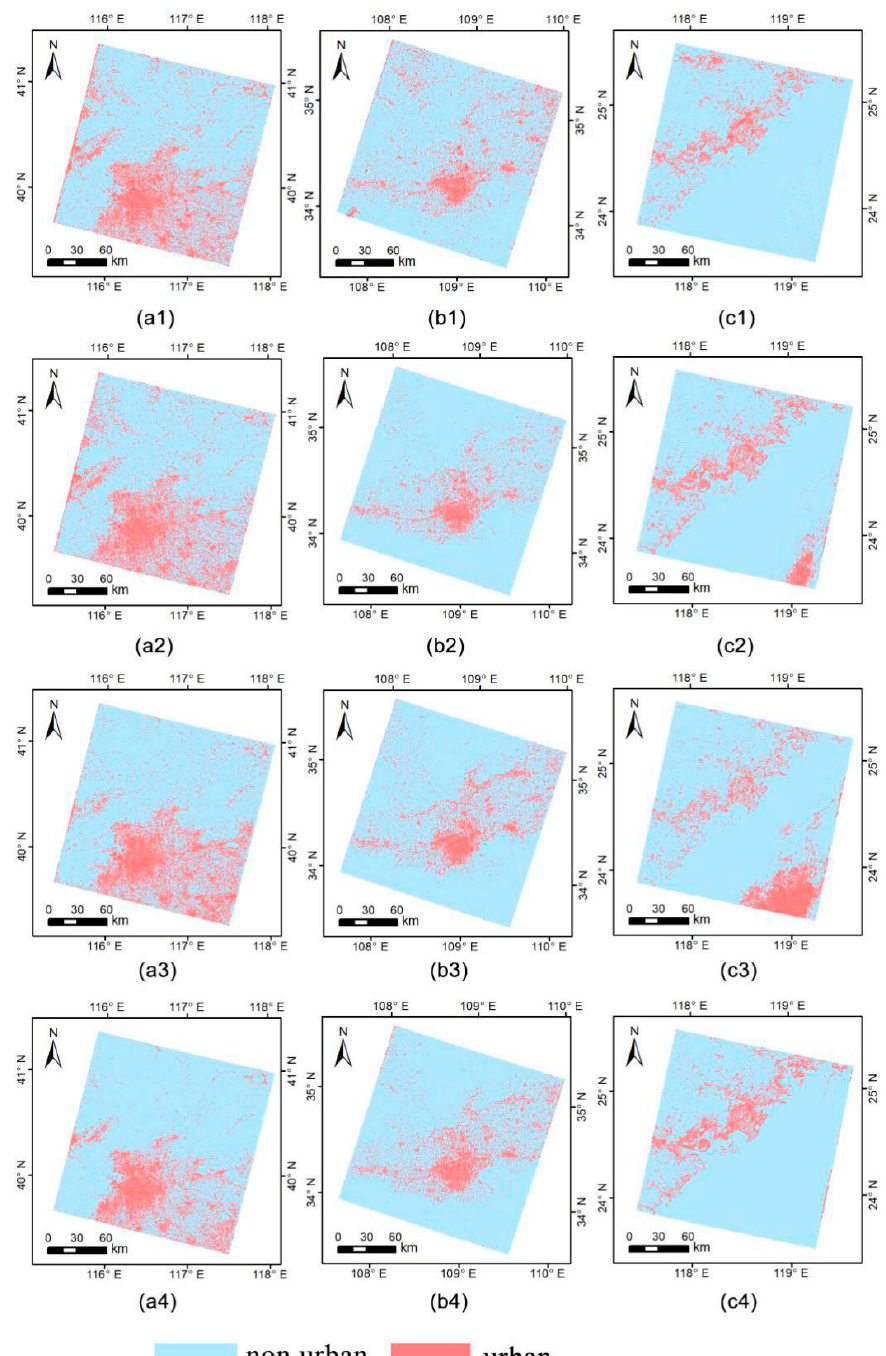
Figure 7. Urban areas mapping results comparison of the four algorithms in the three research areas (( a ), ( b ), and ( c ) represent Beijing, Xi’an, and Xiamen, respectively; 1, 2, 3, and 4 represent the schemes in Table 3).